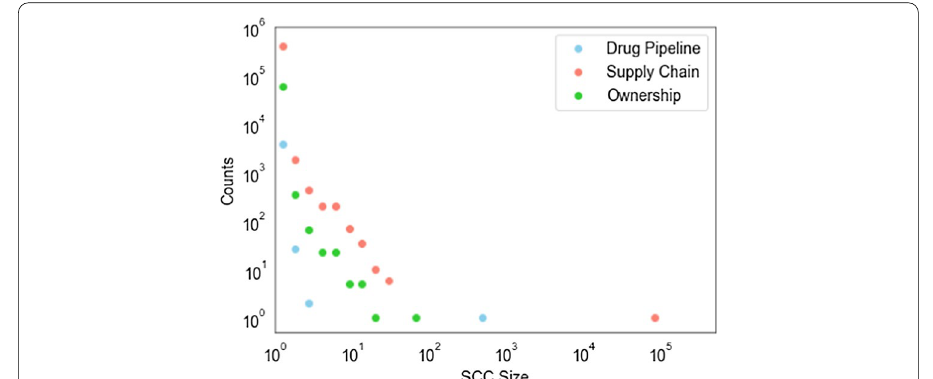
Fig. 7 Distribution of strongly connected component (SCC) size for each layer. The size of SCC is measured as the number of nodes